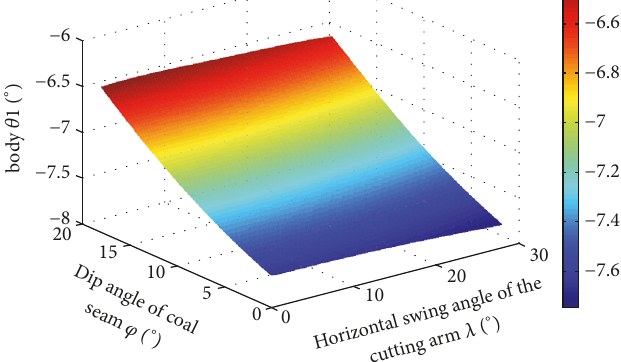
(b) The relationship between 𝜃 1 and the cutting head load in different dip angles of coal seam